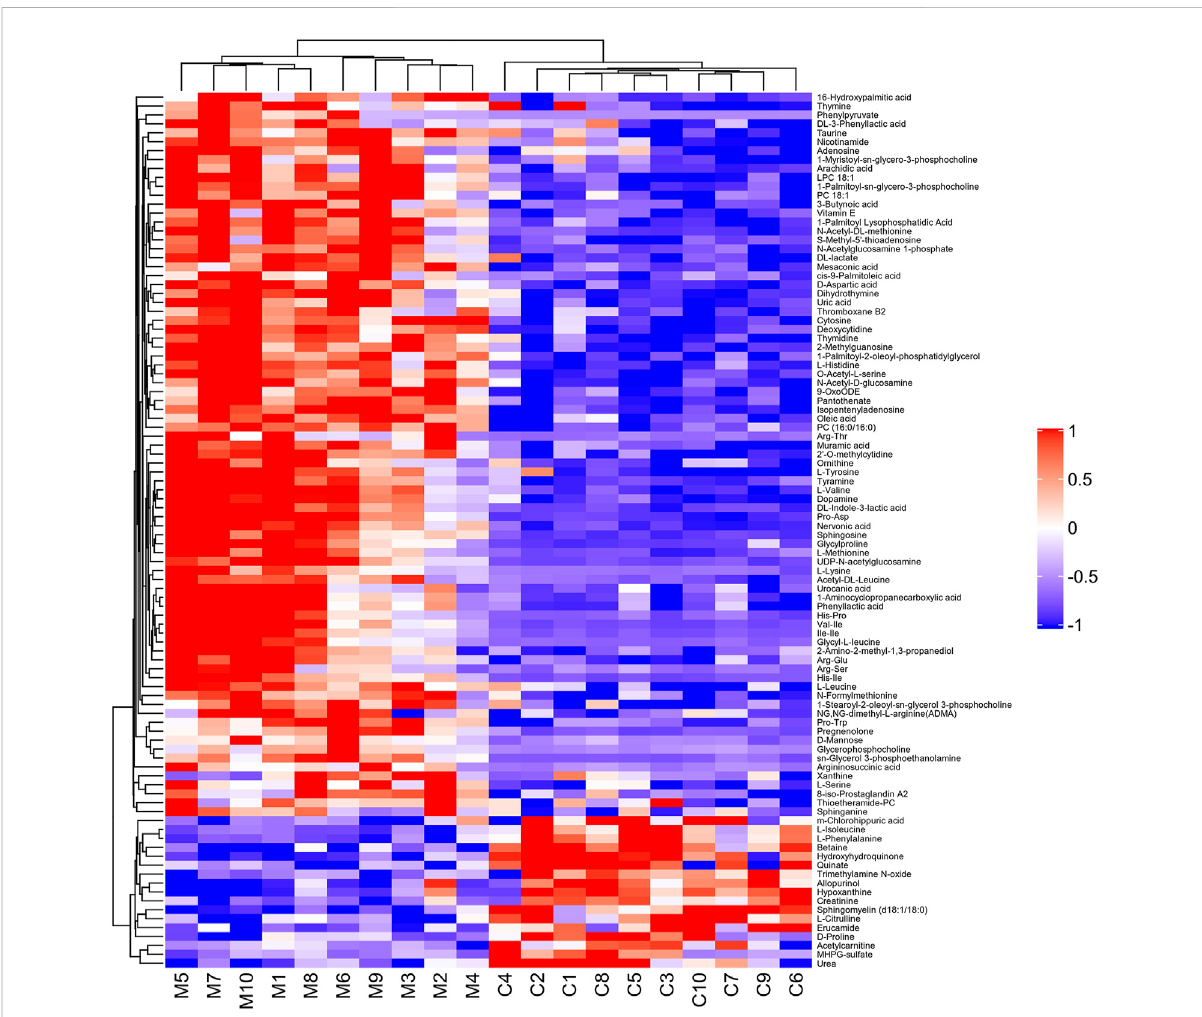
FIGURE 4 Hierarchical clustering heat map of 98 differential metabolites between group C and group M. The values of differential metabolites were normalized and shown as a color scale. Red represents signi fi cant upregulation, blue represents signi fi cant downregulation, and the color scale indicates the level of